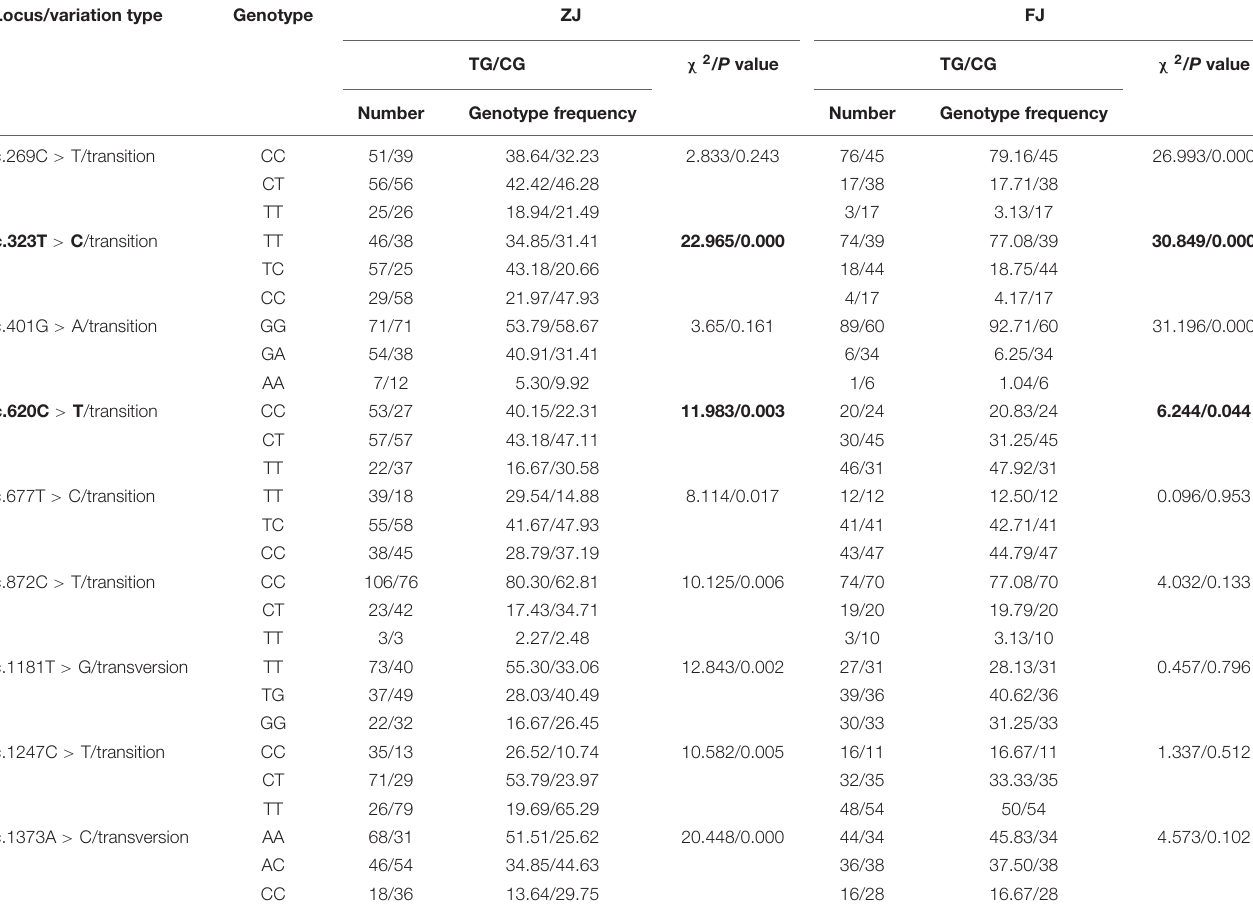
TABLE 2 | Genotype, gene frequency, and variation type of SNPs in Sc-GDH . Locus/variation